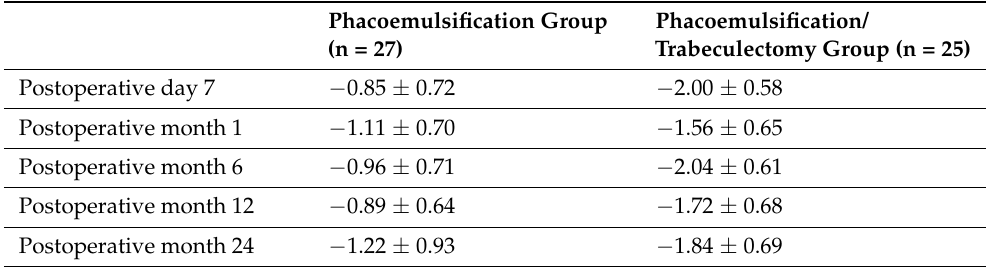
Table 3. Change in the number of anti-glaucoma medications at different time-points compared to the baseline in the two